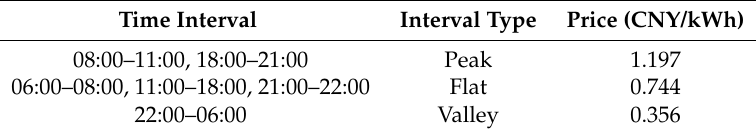
Table A2. Peak/flat/valley electricity price formulated by the Guizhou